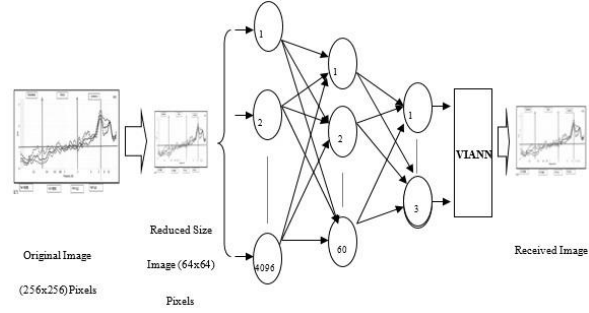
Figure 6. A Recorded Data Spectrum (Site K73) With Neural Network Topology of VIANN.